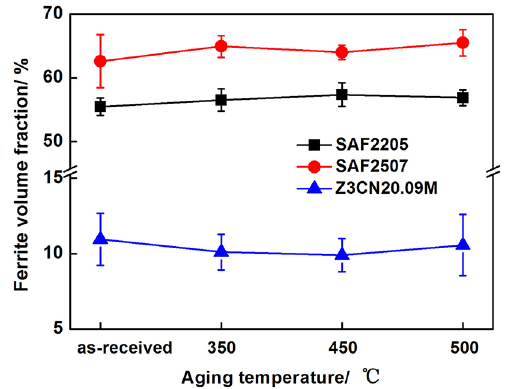
500 ℃ on the basis of phase diagram calculated using Thermo–Calc software 9